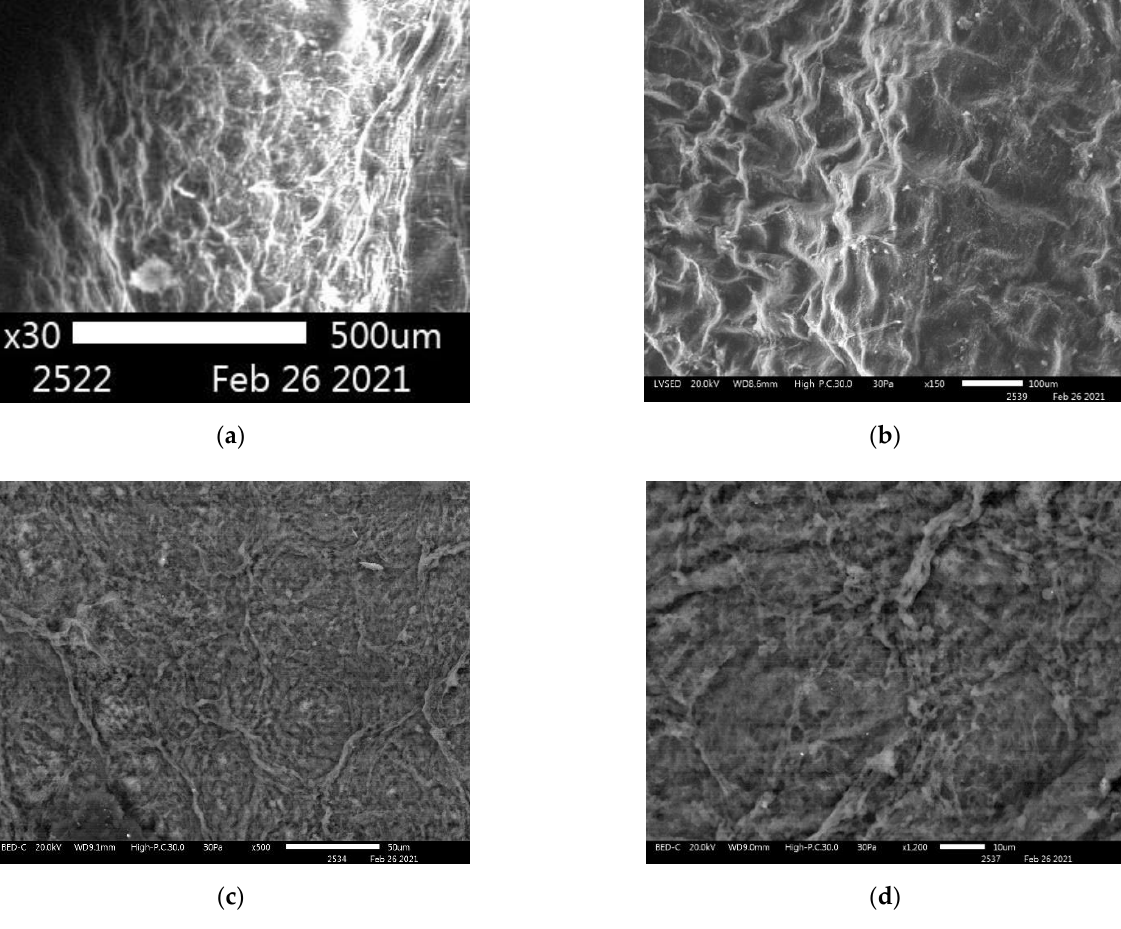
Figure 9. SEM images: BC hydrogel film ×30 ( a ) and ×150 (b ); BC-ZnO NPs-BDP hydrogel film ×500 ( c ) and ×1200 ( d ).